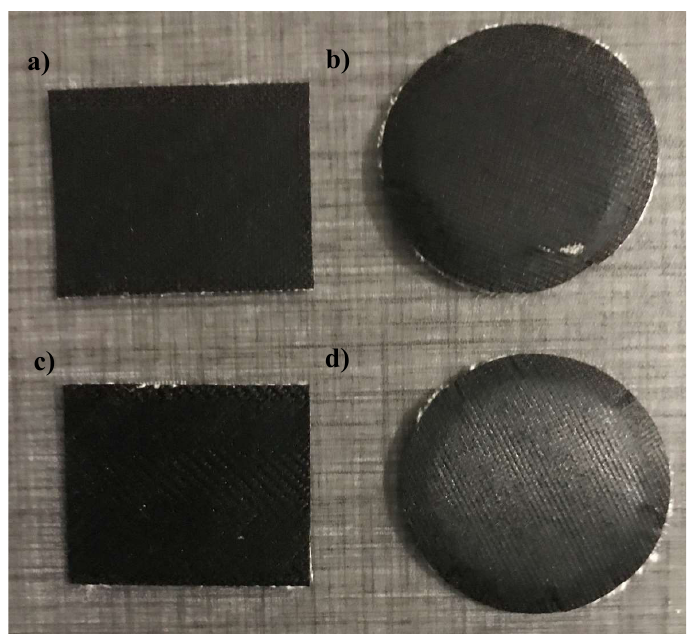
Figure A2. D-PPOT samples ( a , c ) before and ( b , d ) after abrasion experiment. ( a , b ) represent 3D-PPOT made of 18 picks/inch plain fabrics; ( c , d ) ones made from 18 picks/inch twill fabrics.